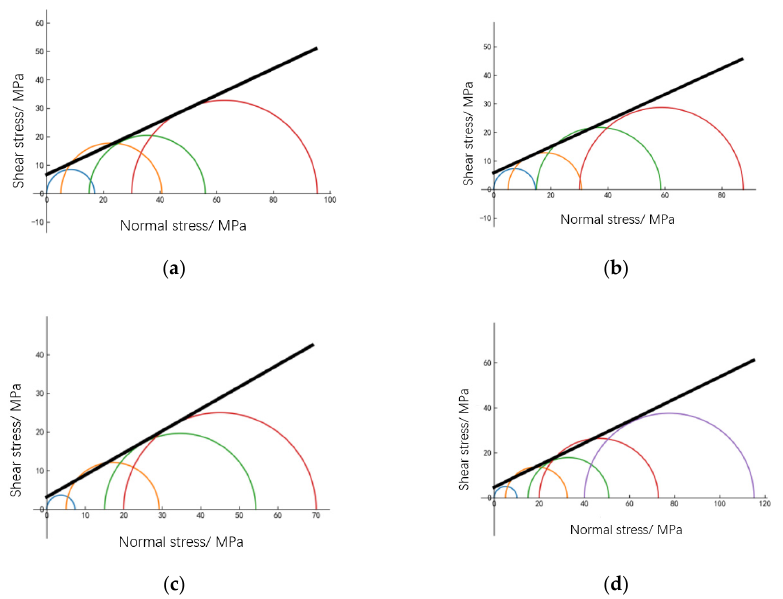
Figure 3. Mohr–Coulomb envelope circle: ( a ) argillaceous sandstone, ( b ) gravel rock, ( c ) gravel–coarse sandstone and ( d ) argillaceous sandstone.